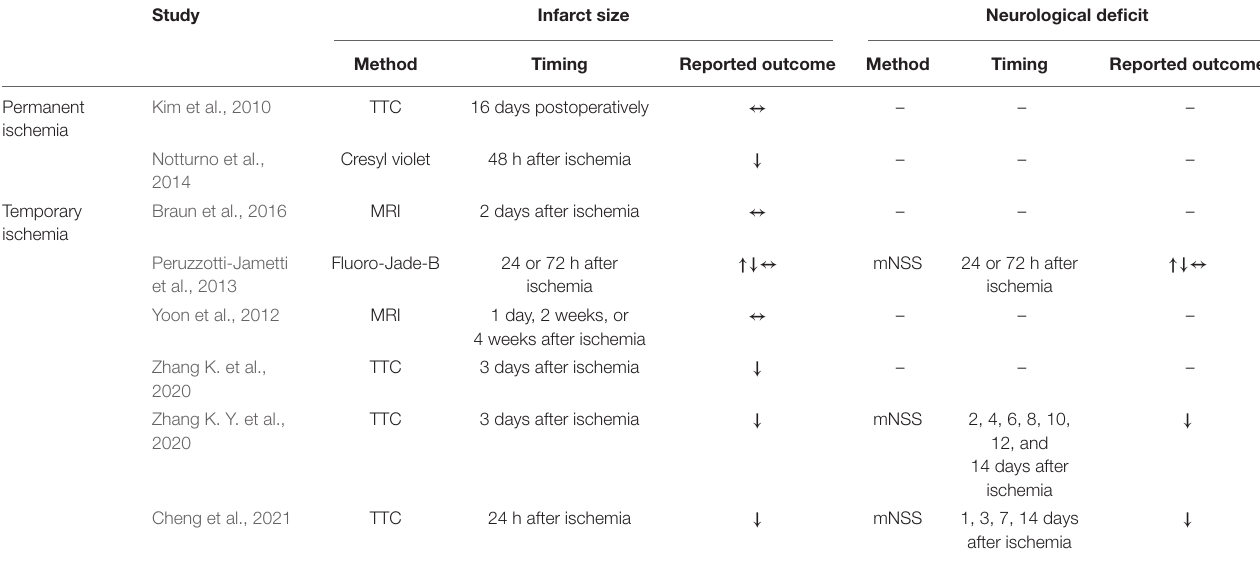
TABLE 2 | Characteristics of outcome evaluations, K =